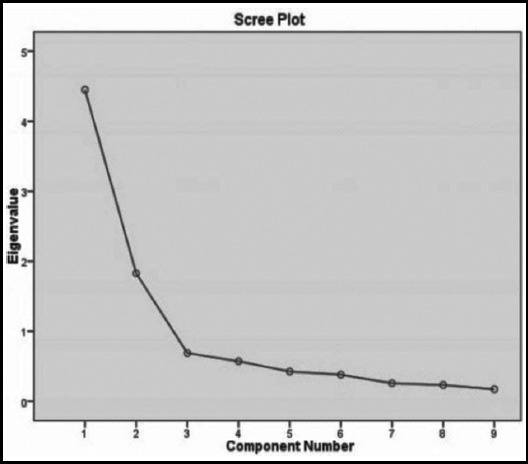
Scree Plot showing two-factor solution with Eigenvalues greater than 1 001, ns= not significant